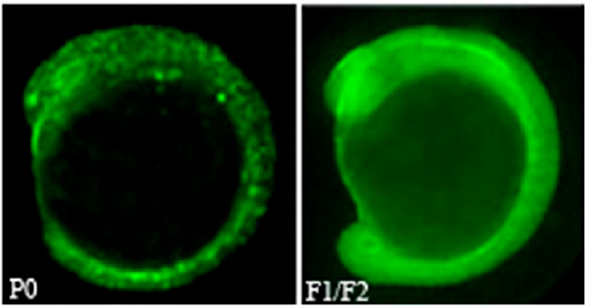
Figure 12. Gfp gene expression in a pCMVT7R transgenic zebrafish embryo of mid-somite stage. The P0 embryo expressed the gfp gene mosaically; F1/F2 one expressed the gfp gene uniformly in the whole embryo [71].